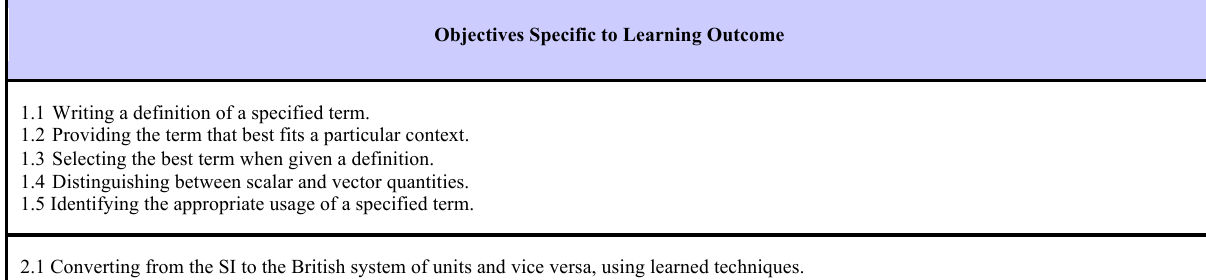
Objectives Specific to Learning